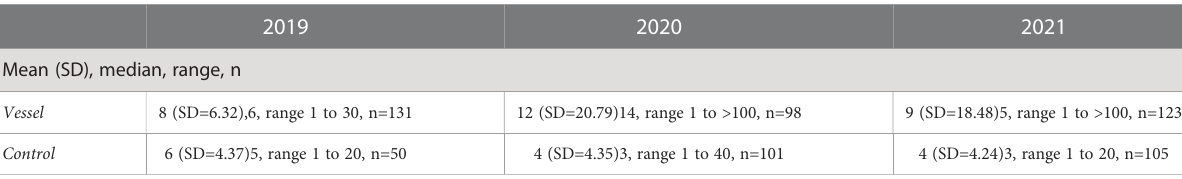
TABLE 5 Mean and median group size during focal follows in 2019, 2020 and 2021.